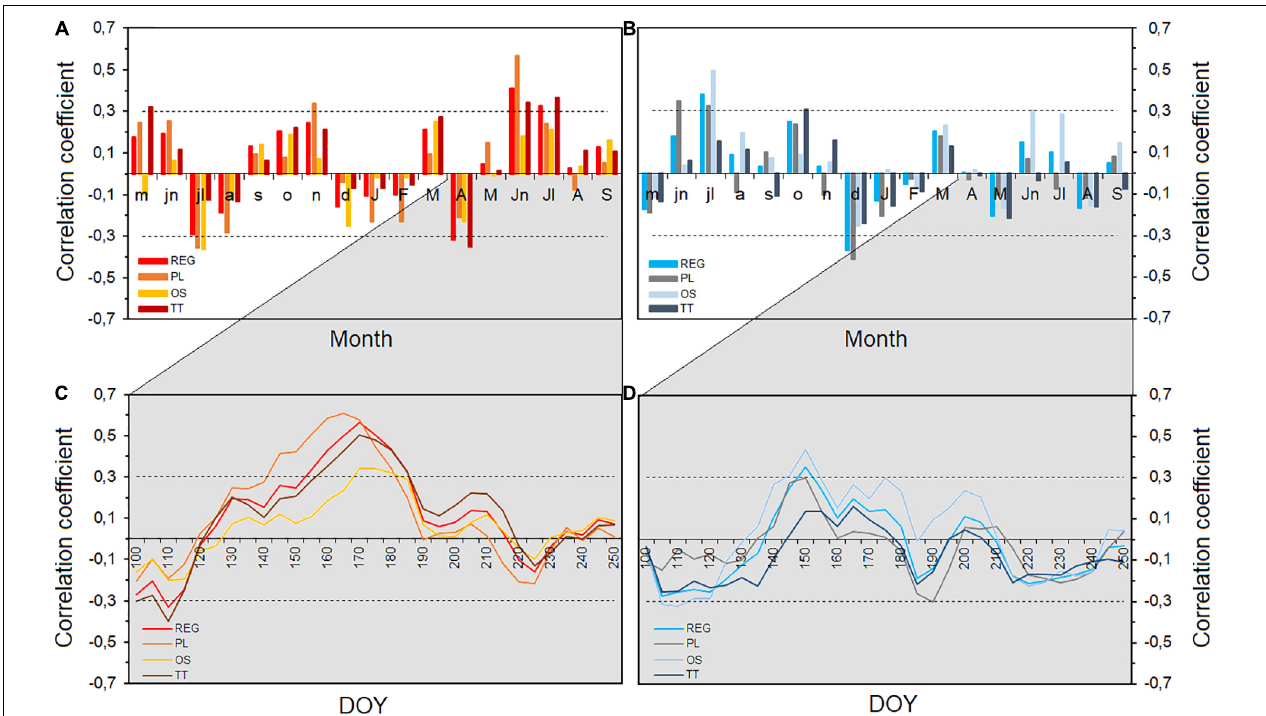
FIGURE 2 | (A) Monthly correlation of tree-ring width standardized regional and site chronologies (REG, PL, TT, and OS) with temperature and (B) with precipitation from May of the previous year to September of current year for the common period 1971–2011. Moving correlation from April to September [100–250 days of the year (DOY)] (window = 20 days and step = 5 days) with temperature (C) and precipitation (D) . Horizontal dashed lines show significant correlations at p <